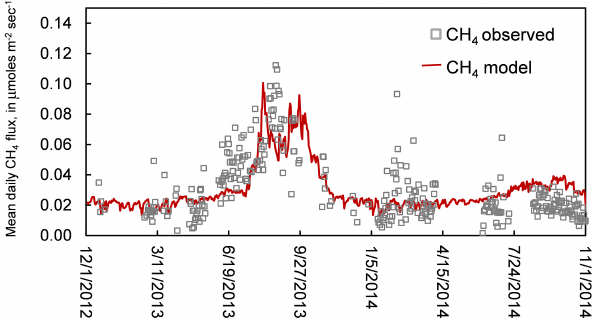
Figure 3. Observed and computed mean daily molar methane (CH 4 ) flux at the Dwarf Cypress site.